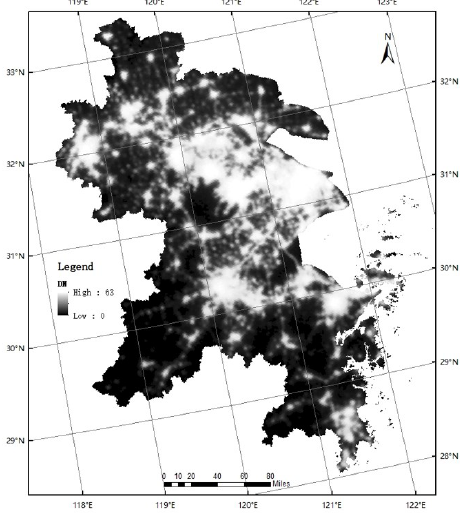
Figure 2 . DMSP/OLS nighttime light data in 2020